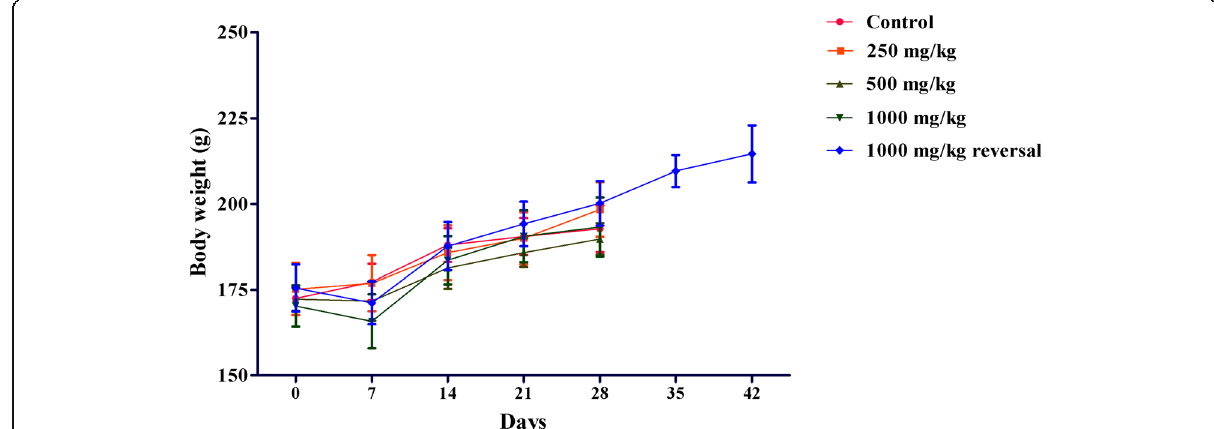
Fig. 4 Effect of 28-day treatment with Asdamarin on body weight of female rats. Values are expressed as mean ± s.e.m. ( n = 5). * p < 0.05 were considered significant using one-way